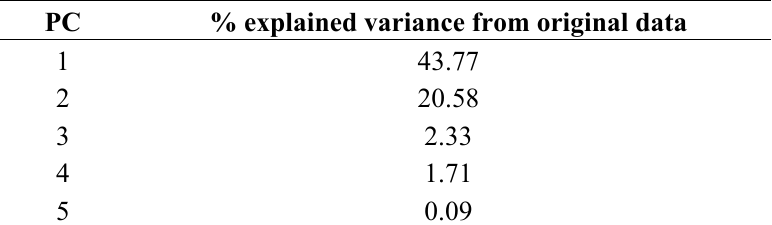
Table 4. Results of PCA analyses of anti- Candida activities.